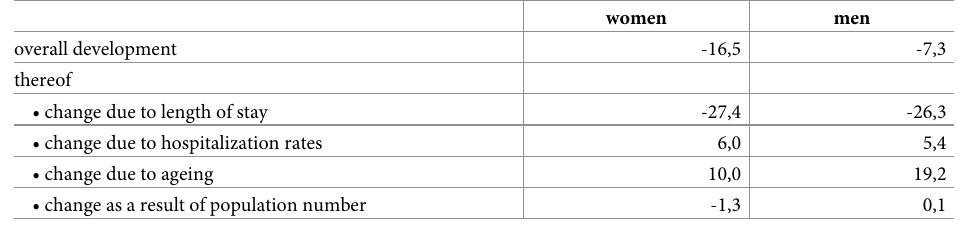
Table 5. Development of the number of treatment days (in %), 2000–2015, results of decomposition analysis.